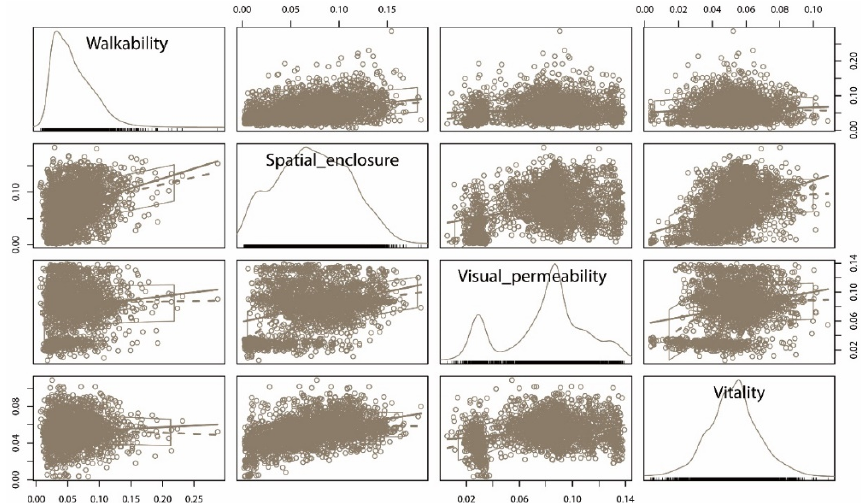
Figure 7. Data distribution of four dimensions and their inconsistency with each other.